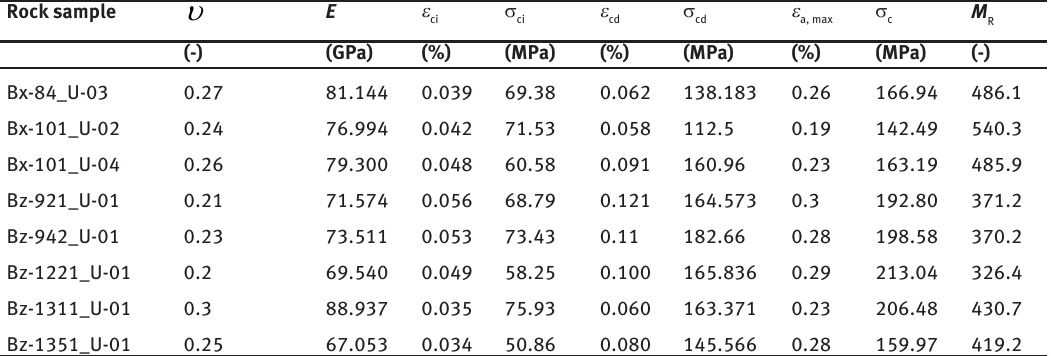
Fig. 4.: A prepared sample in the beginning of the UCS test.